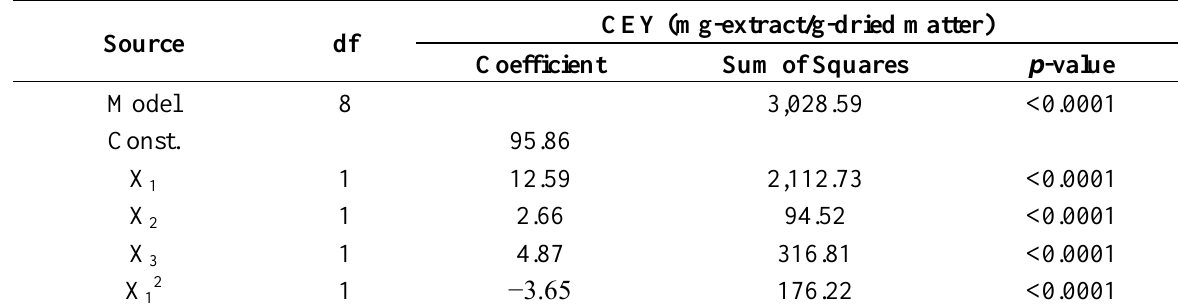
Table 2. Analysis of variance (ANOVA) and coefficients of the final reduced regression equation. Source